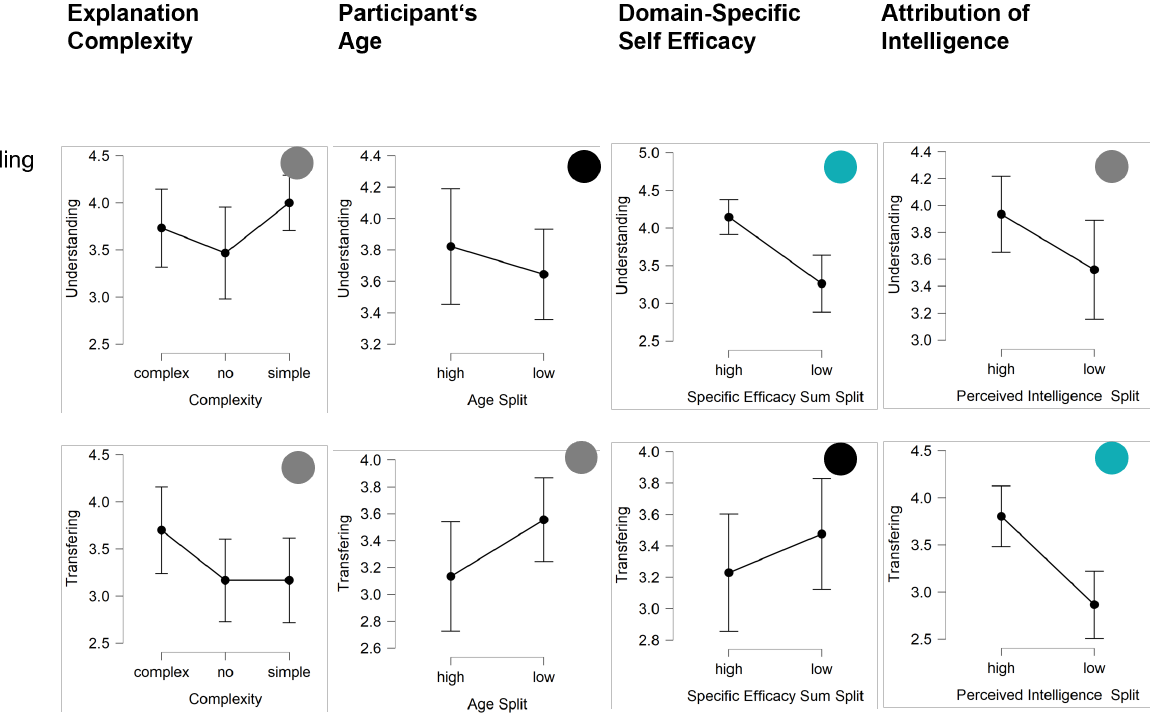
Figure 7. Results regarding epistemic explanation objectives (understanding and transferring). The first column shows the impact of explanation complexity (complex, no, simple). The other columns show the influence of the human dimensions (age, domain-specific self-efficacy, and mind